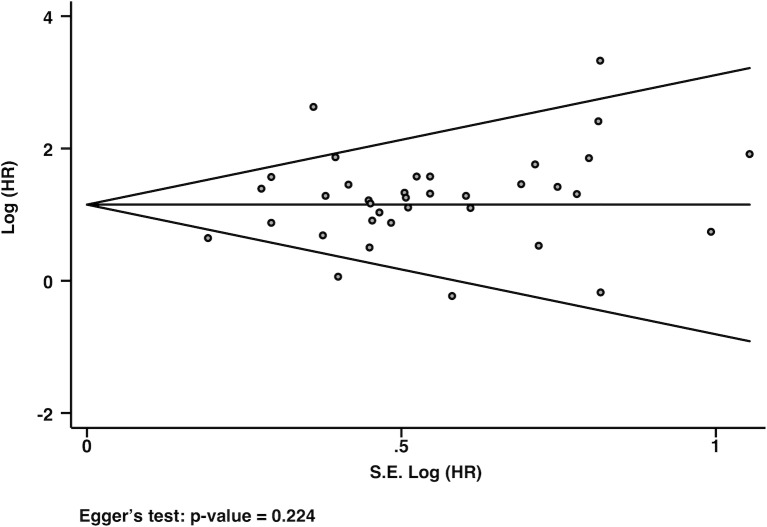
Funnel plot representing the analysis for publication bias with Egger’s test for bias.Each dot represents a study; the y-axis represents study precision (95% CIs), and the x-axis shows the SE of the HR. CI, confidence interval; HR, hazard ratio; SE: standard error.